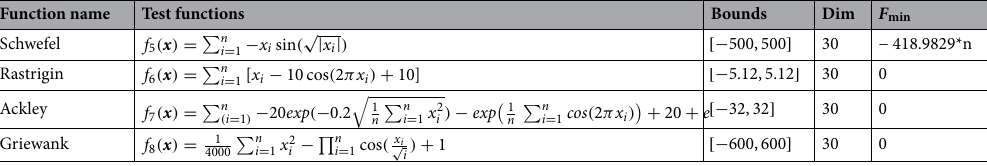
Table 2. Multimodal benchmark